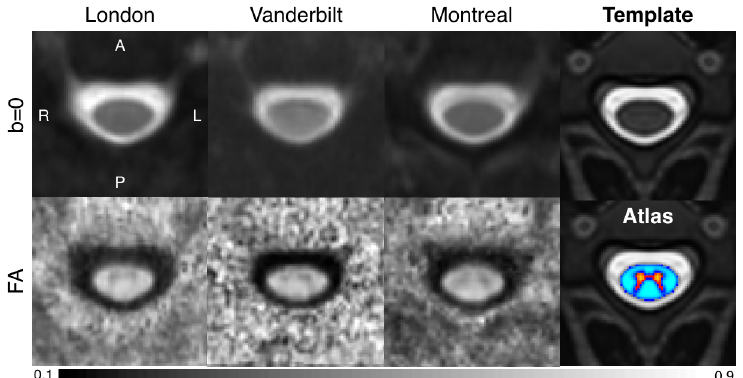
Fig 4. Results of registration to the MNI-Poly-AMU template and group averaging (N = 5; different subjects were scanned at each site) for sites 1 (London), 2 (Vanderbilt) and 3 (Montreal) (b = 0 images are shown in the top row, and FA maps in the bottom). The 4 th column shows the T 2 -weighted template (top) and the white/grey matter probabilistic atlas